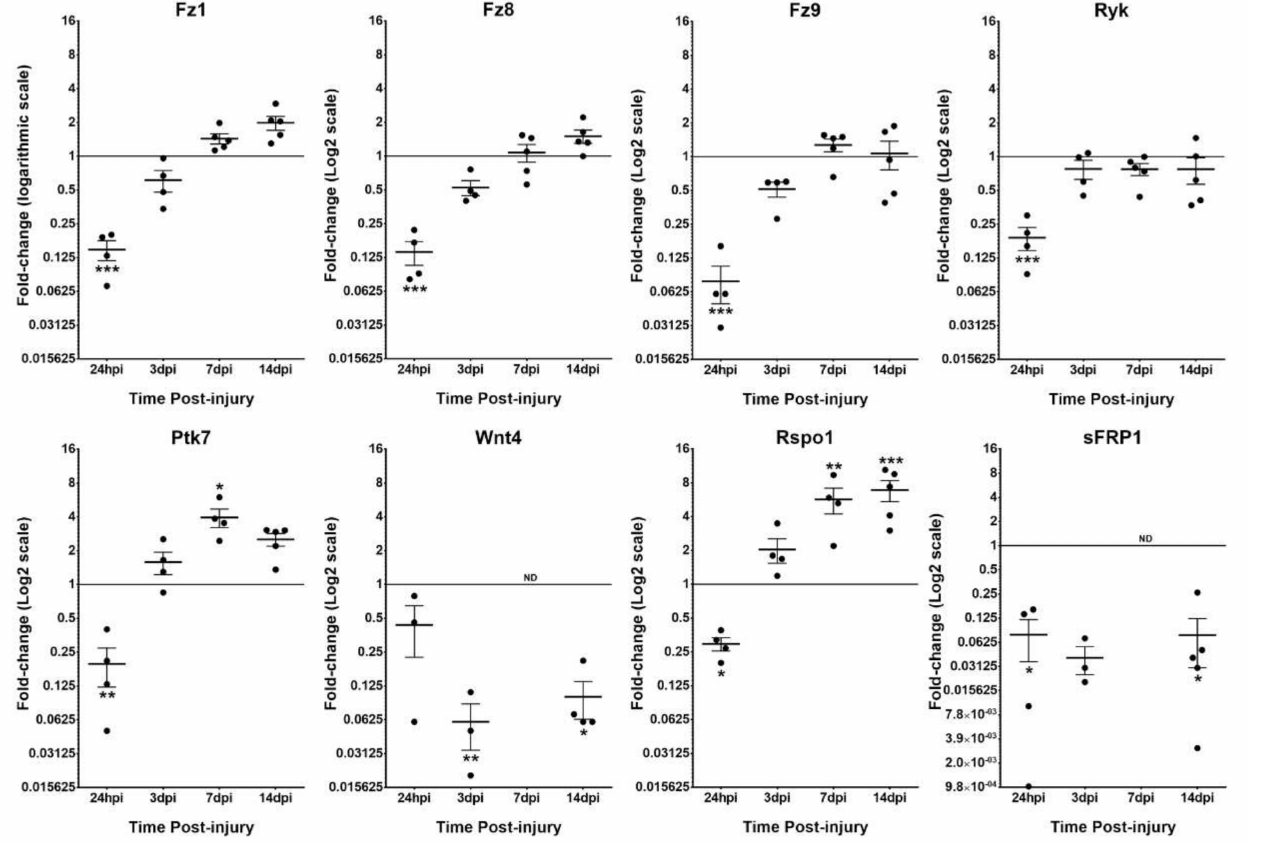
Figure 1. mRNA expression analysis of Wnt-related molecules in spinal cord-isolated microglia at different times post-injury and compared to uninjured conditions. The figure shows mRNA expression data corresponding to different detectable Wnt signaling-related molecules in spinal cord isolated microglial cells at different times post-injury and compared to microglia that were isolated for the intact spinal cord. Data represent 2 ∆∆ Ct mean ± SEM. * p < 0.05; ** p < 0.01; *** p <